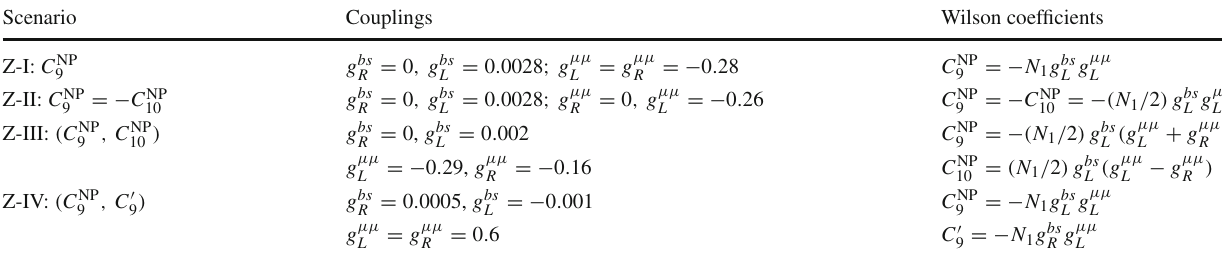
Table 2 1D and 2D favoured NP scenarios that can be generated in Z (cid:4) model Scenario Couplings Wilson